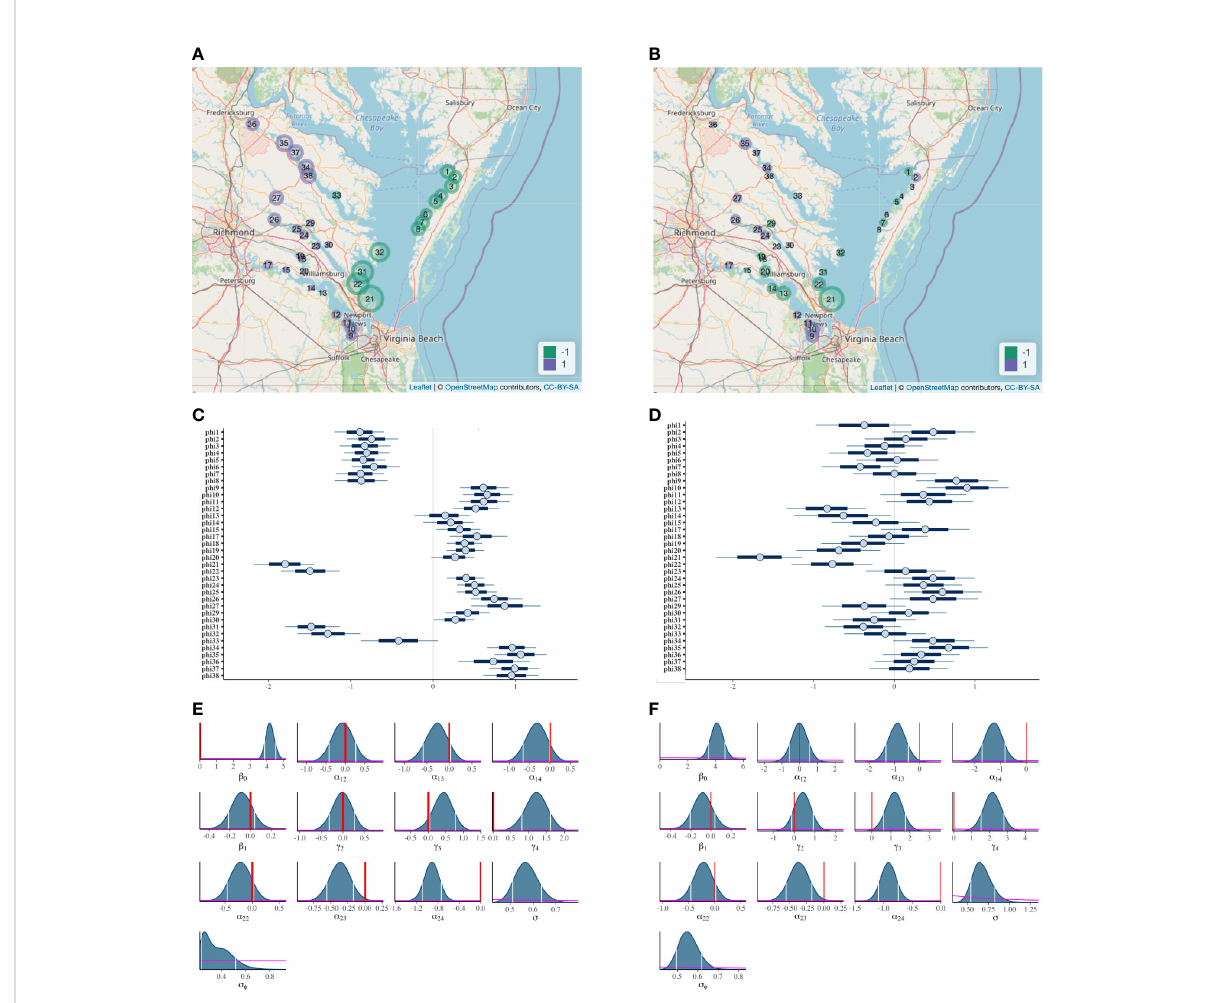
FIGURE 5 Bayesian inference results from the ICAR model of Eqs. (1) – (6) (panels A , C , and E ) and uncorrelated model (panels B , D , and F ). Panels (A, B) : bubble plot of f i (marsh site effect), where a large purple bubble represents a highly positive value for the estimated marsh site effect (posterior median of f i ), and a large green bubble, a highly negative value. Panels (C, D) : Bayesian con fi dence intervals for f i at con fi dence levels of 50% (dark blue line) and 80% (light blue line); circles denote estimated marsh site effects. Panels (E , F) : marginal posterior distributions for the regression coef fi cients and variance parameters, with 80% con fi dence intervals delimited by white vertical lines, prior distributions shown in magenta, and the value 0 marked in red for the regression coef fi